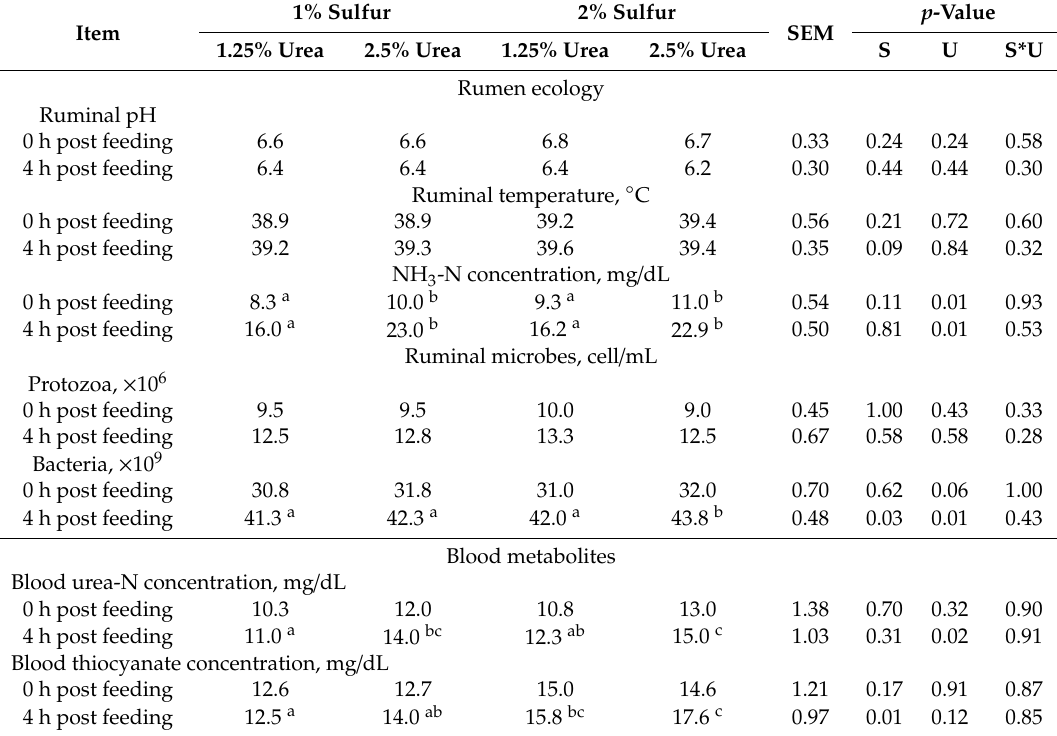
Table 3. E ff ects of fermented total mixed ration on rumen ecology, microorganism, blood urea-nitrogen and blood thiocyanate in dairy